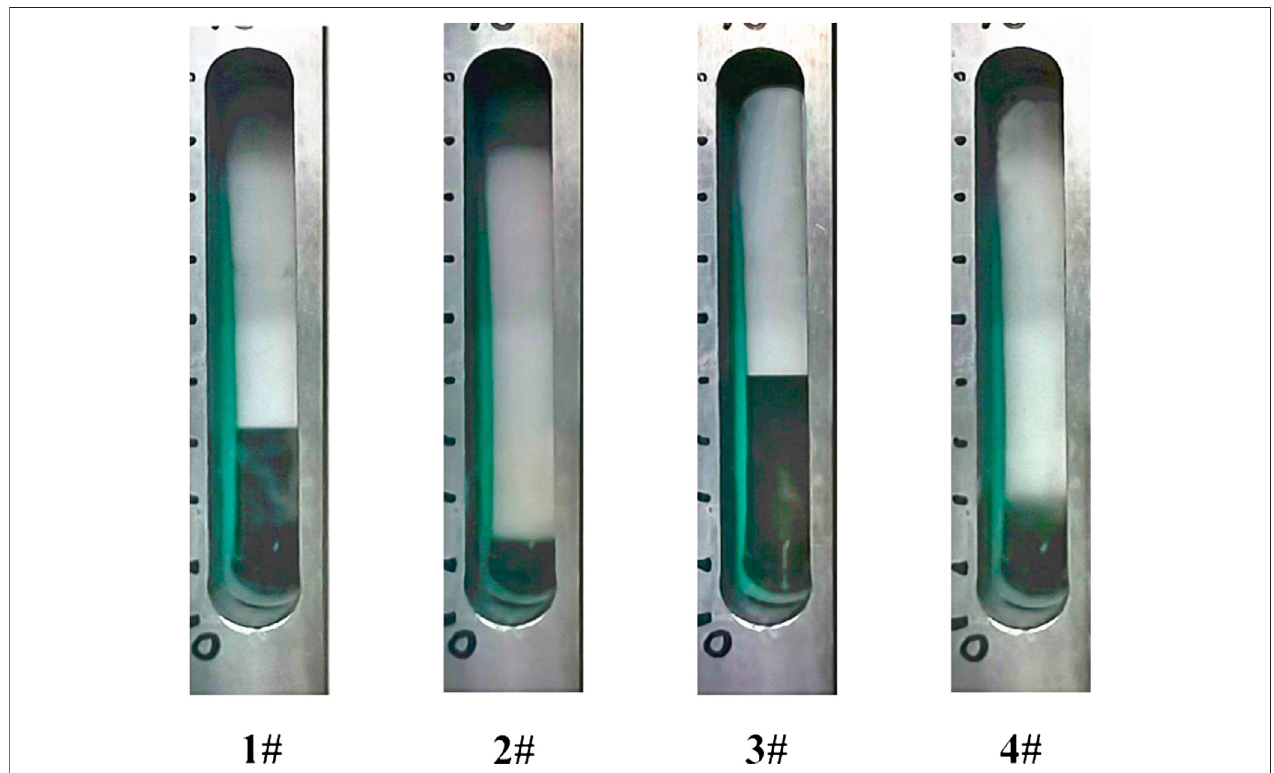
FIGURE 9 | Performance evaluation experiment of foaming of viscosity